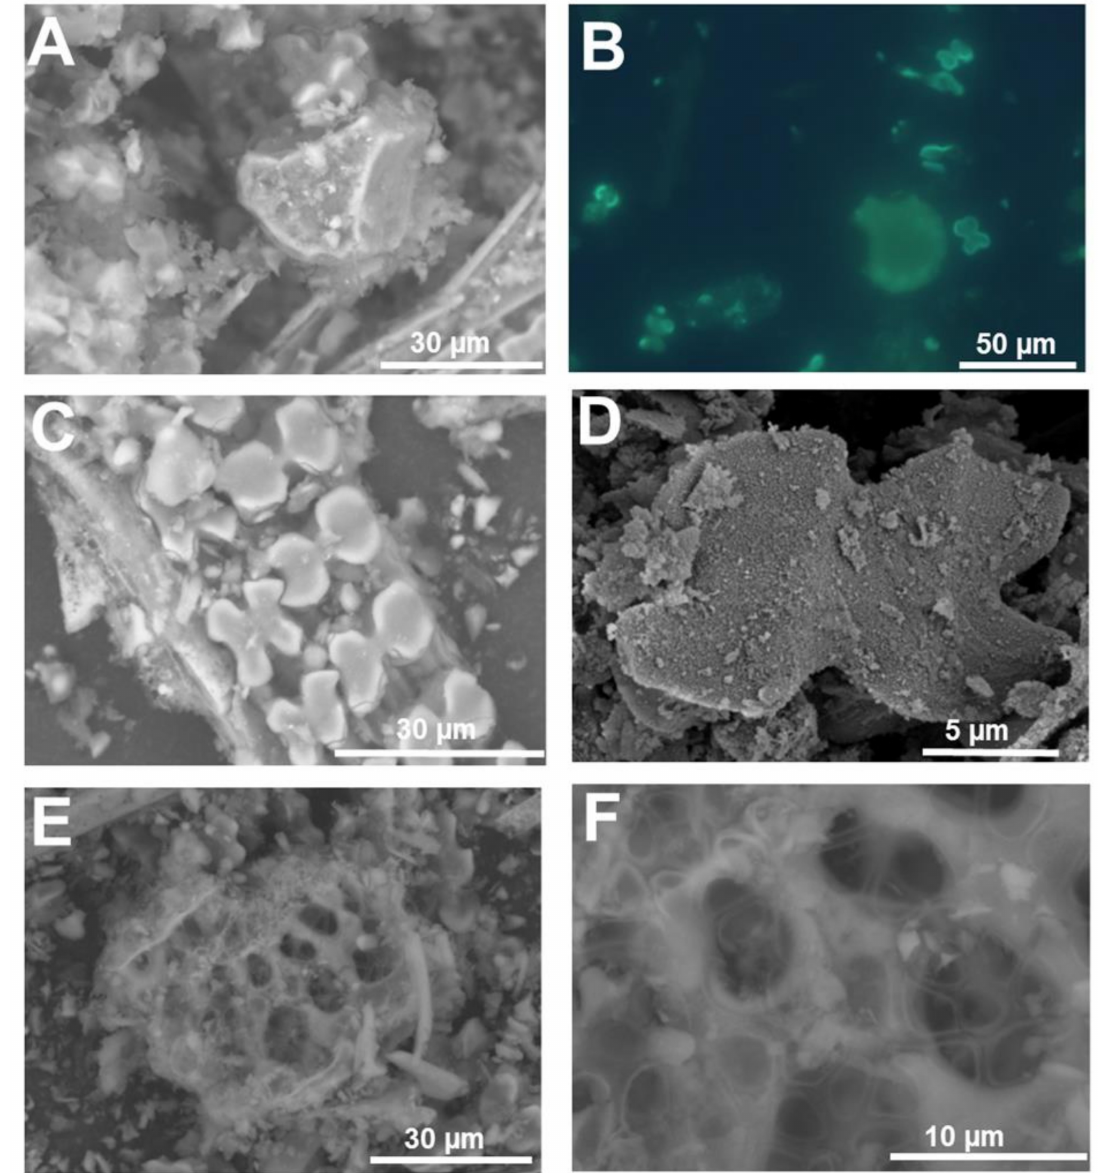
Figure 5. SEM (topographic contrast) and fluorescence microscopy images of the silica extracted from rice leaf. ( A ) Bulliform cells with silicified fibrous material. ( B ) Bulliform cell and silica cells stained with PDMPO. ( C ) Dual-layer of silica cells. ( D ) Fine detail of the silicified granules present on the surface of a silica cell. ( E , F ) Probable multicellular silicified pedestal of a rice trichome. Images ( A , C , E , F ) were taken using a HITACHI TM3000 TableTop SEM. Images ( B ) and ( D ) were taken using an Olympus BX50 fluorescence microscope and a Hitachi S-4500 SEM,